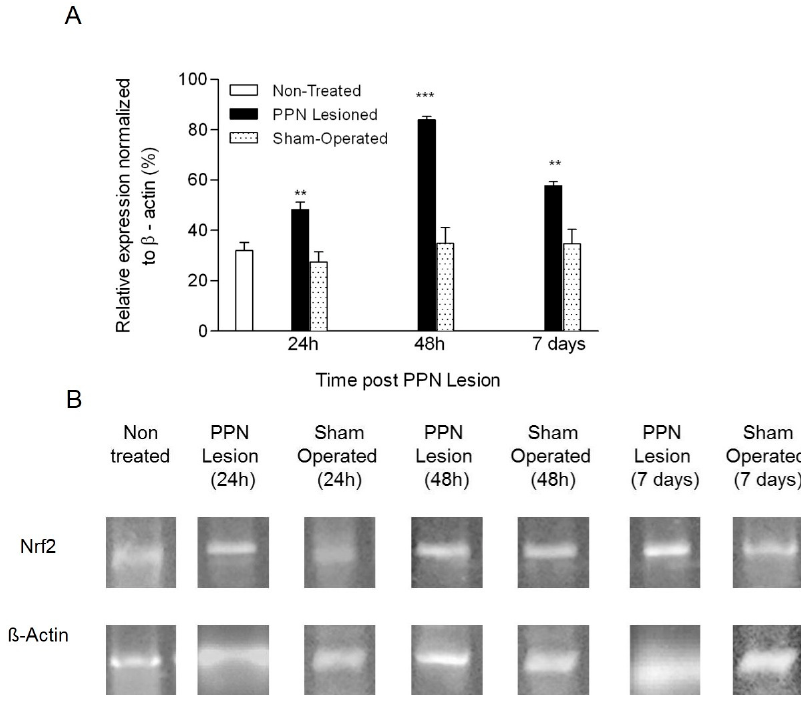
Figure 9. Effect of pedunculopontine nucleus (PPN) neurotoxic lesion on the nuclear factor (erythroid ‐ derived 2) ‐ like 2 ( Nrf2 ) mRNA expression in nigral tissue. ( A ) Comparison between experimental groups 24 h, 48 h and 7 days after PPN lesion (F (6,29) = 39.08 p < 0.001). The first bar (white bar) represents the non ‐ operated group. Asterisks correspond to statistical differences between PPN lesion and both control groups (non ‐ operated and sham operated). ( B ) Agarose/ethidium bromide gel electrophoresis bands representative of the semi ‐ quantitative RT ‐ PCR study for Nrf2 mRNA expression. One ‐ way ANOVA test. ** p < 0.01; *** p < 0.001.